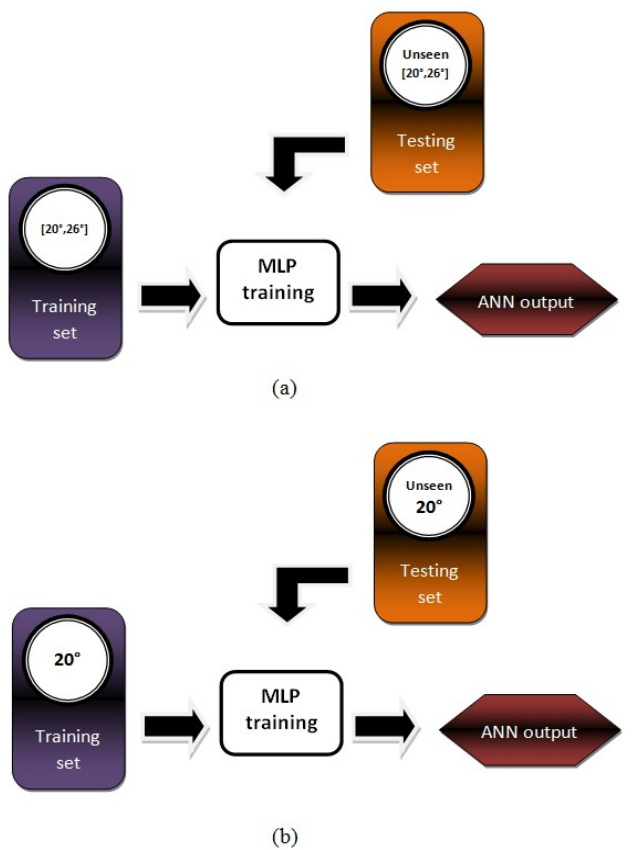
Figure 7. A schematic diagram of experimental method towards developing neural oil fraction sensors based on ( a ) generic θ ; and ( b ) fixed-size θ